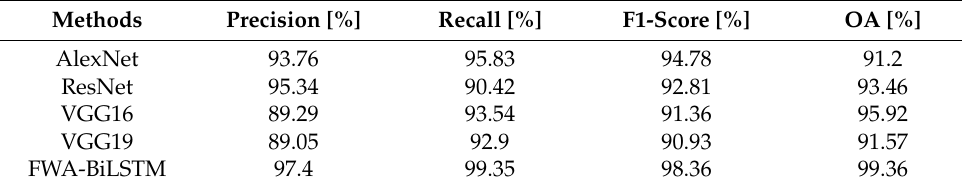
Figure 11. Deep learning techniques on SVD dataset.